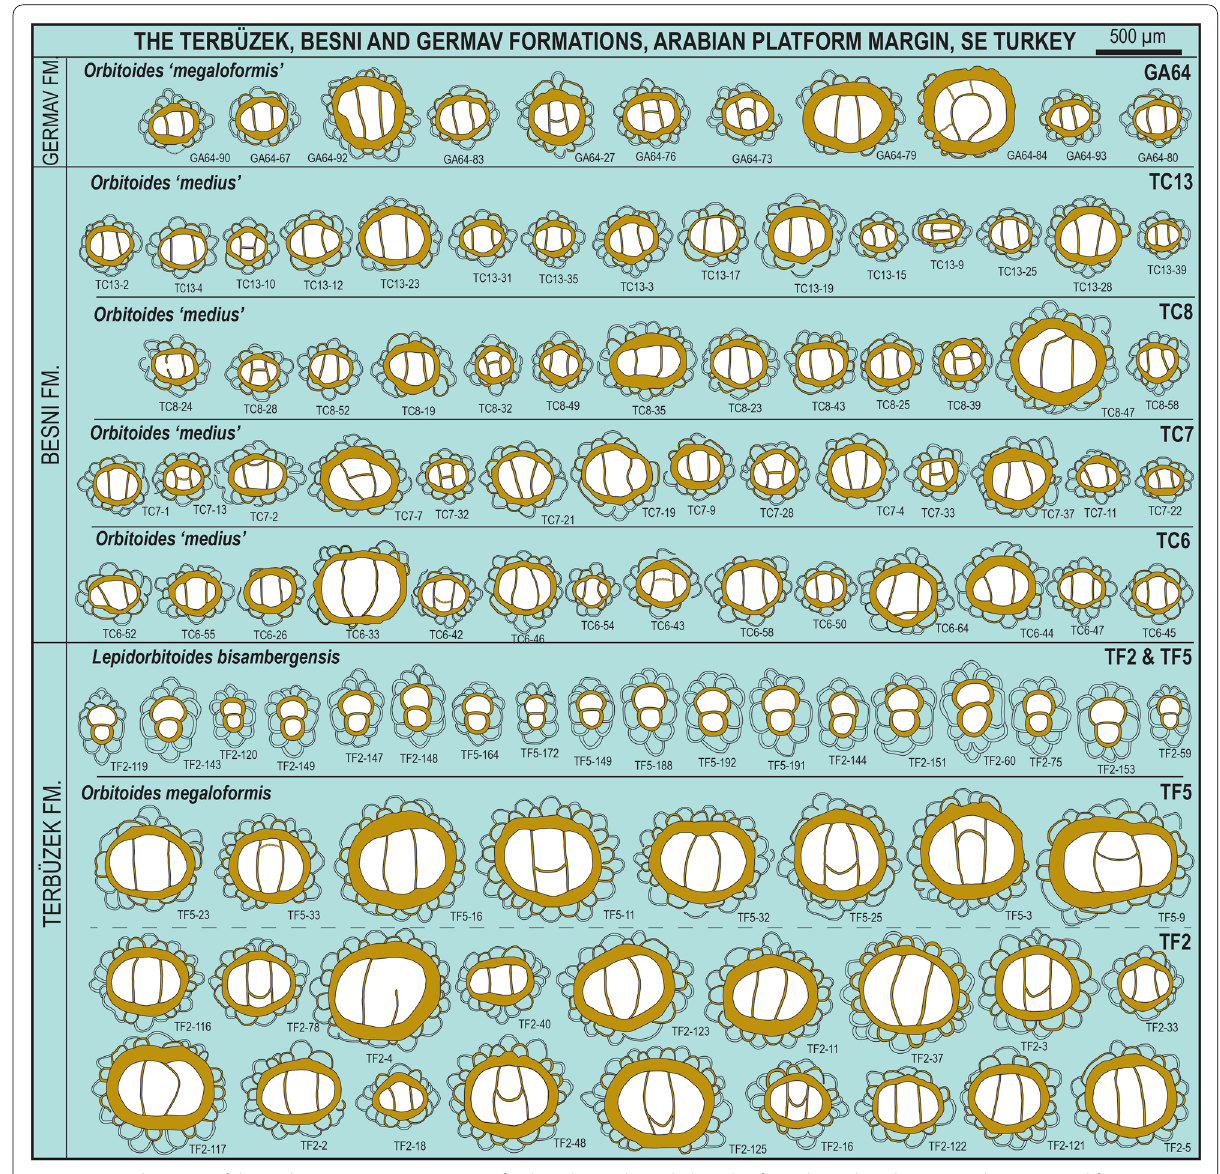
Fig. 19 Line drawings of the embryonic–nepionic stages of Orbitoides (and Lepidorbitoides ) from the Terbüzek, Besni and Germav and formations, SE Turkey, Arabian Platform